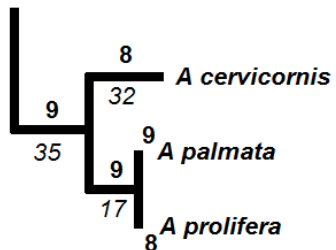
Figure 6. Subset of the larger tree (Figure 2) with the three Acropora species endemic to the Caribbean. Relevant branch lengths are shown below the branch, in italics. Numbers in bold at the top of the branches indicates the number of ecosystems in which the species or branch is represented (present) (according to